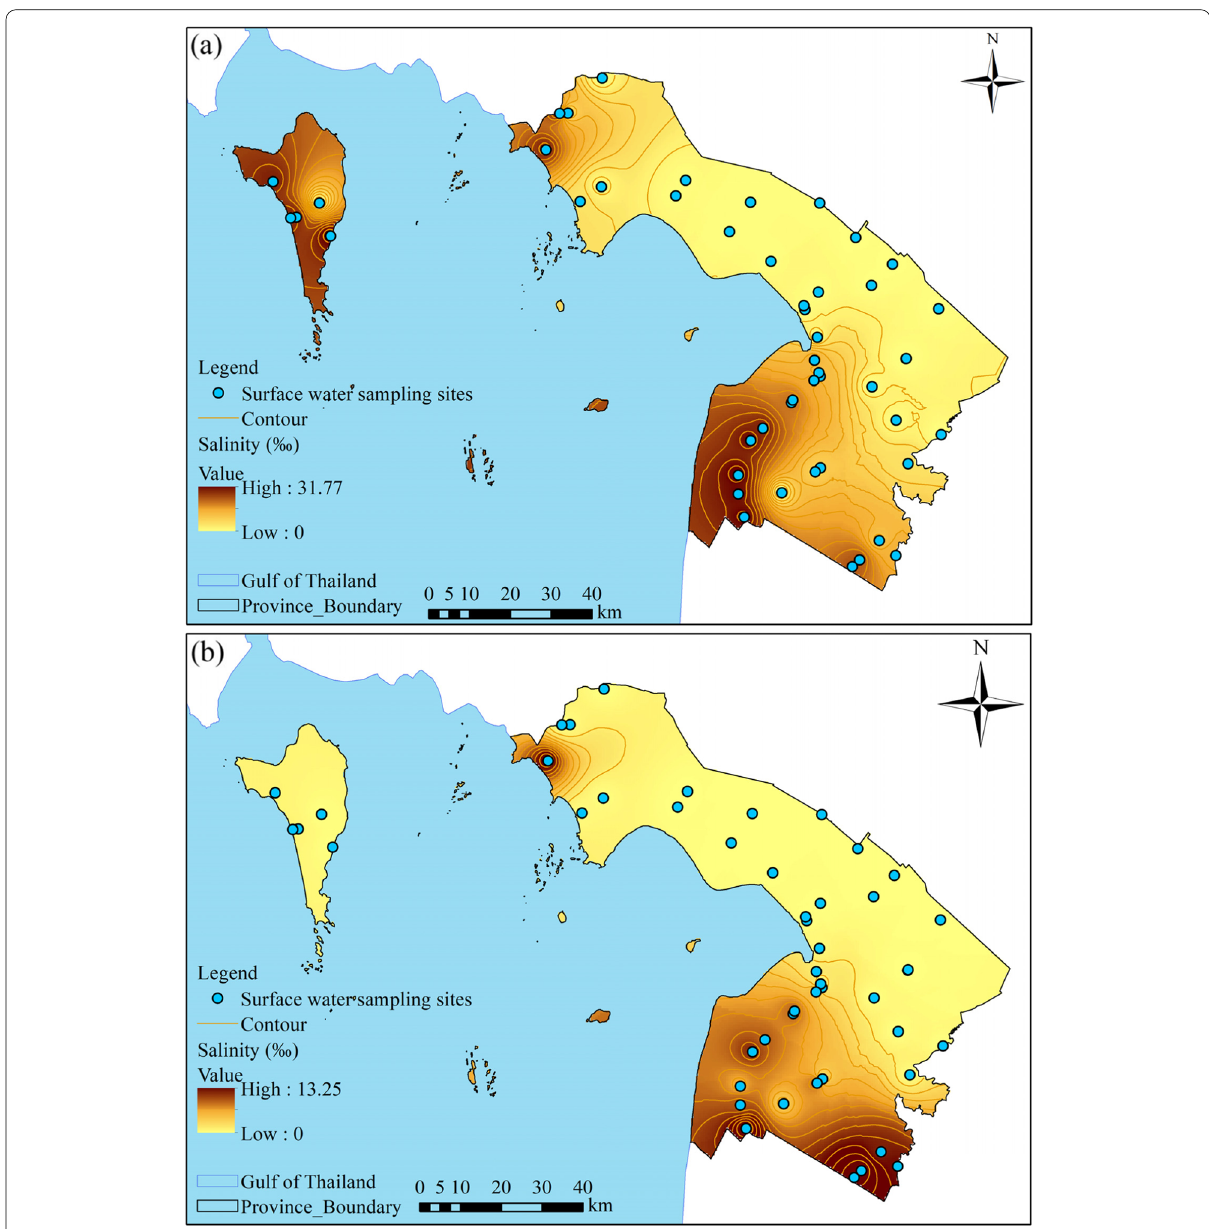
Fig. 3 Map of salinity distribution in ( a ) dry season and ( b ) rainy season of Kien Giang